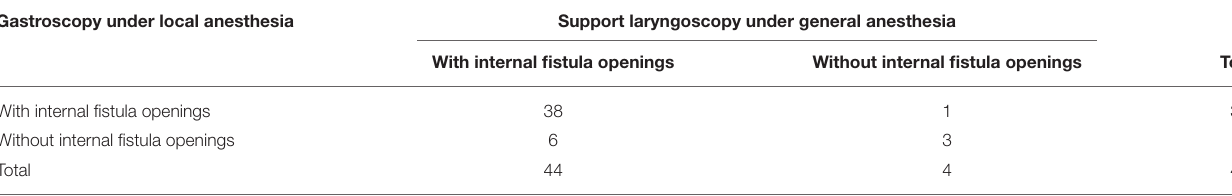
TABLE 3 | Four-fold table exploration conditions of the internal fistula openings of CPSF using two diagnostic